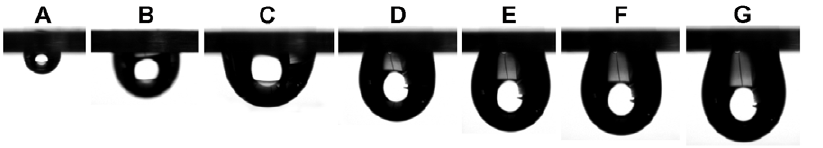
Figure 2. Optical images of different volumes of water droplets hanging on the dry wing surface of cicada Cryptotympanaatrata collected in the year 2010. (A) 3 m L; (B) 20 m L; (C) 30 m L; (D) 35 m L; (E) 37 m L; (F) 39 m L; (G) 42 m L.